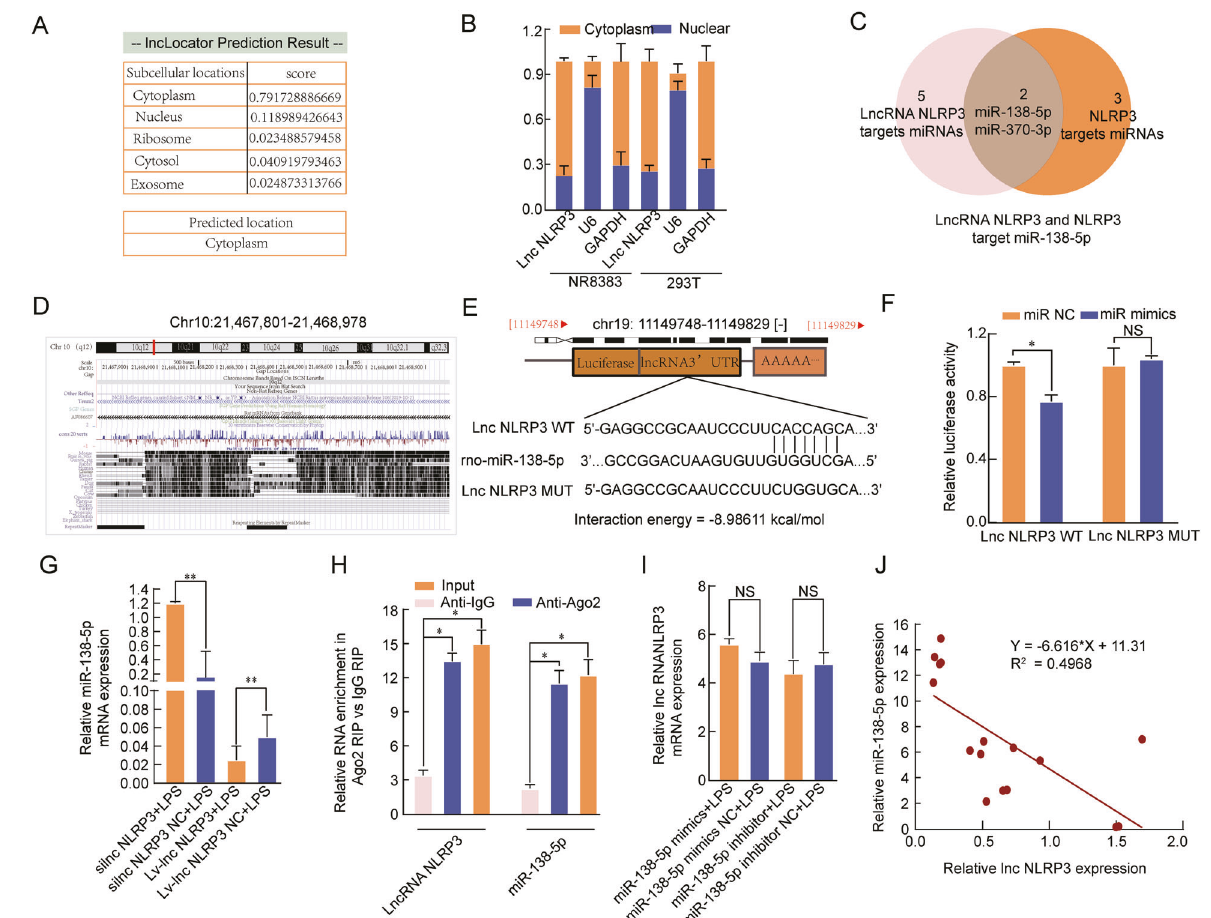
NLRP3 and NLRP3. D , E The predicted miR-138-5p-binding sites in the lncRNA NLRP3 3 ′ -UTR. F miR-138-5p mimics notably reduced the luciferase activity of the lncRNA NLRP3-Wt group. G silncRNA NLRP3 signi fi cantly increased miR-138-5p expression; however, overexpression of lncRNA NLRP3 reduced miR-138-5p expression in LPS-treated NR8383 AM cells. H RIP assays revealed that Ago2-containing beads enriched the expression of miR-138-5p and NLRP3. I The miR-138-5p inhibitor and miR-138-5p mimics had no effects on lncRNA NLRP3 expression in LPS-treated NR8383 AM cells. The data are presented as mean ± SE ( n = 6). J LncRNA NLRP3 expression was negatively correlated with miR- 138-5p expression in LPS-treated NR8383 AM cells. * P < 0.05; ** P < 0.01; *** p < 0.001; NS, no statistically signi fi cant